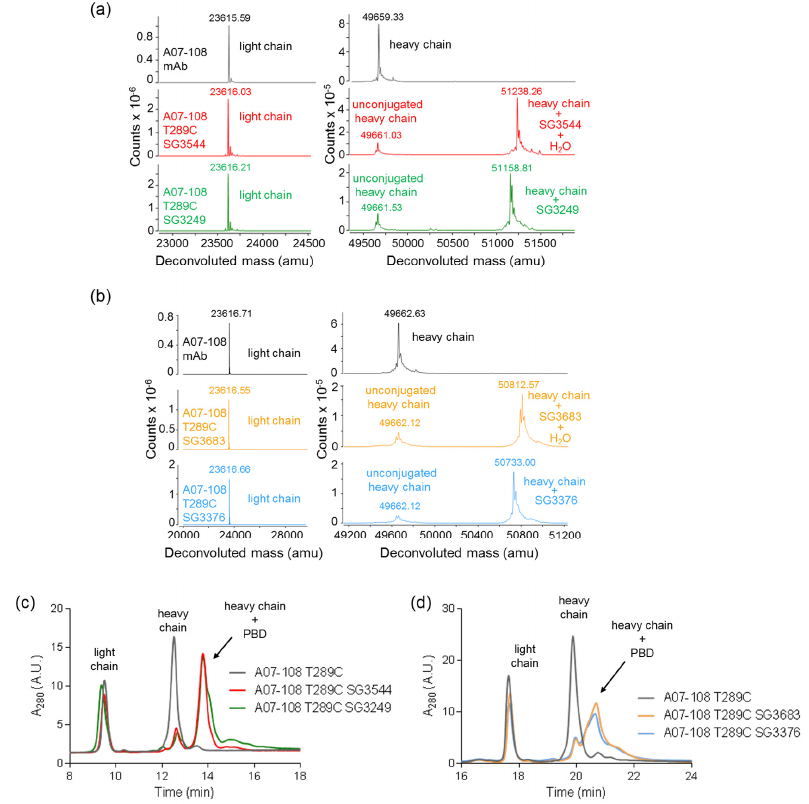
Figure 2. Characterization of A07-108 T289C antibody-drug conjugates (ADCs). ( a ) Reduced deglycosylated mass spectrometry analysis of antibody before and after conjugation of cleavable pyrrolobenzodiazepine (PBD) drug-linkers SG3249 and SG3544; ( b ) Reduced deglycosylated mass spectrometry analysis of antibody before and after conjugation of non-cleavable PBD drug-linkers SG3376 and SG3683; ( c ) rRP-HPLC analysis of antibody before and after conjugation to cleavable PBD drug linkers SG3249 and SG3544; and, ( d ) rRP-HPLC analysis of antibody before and after conjugation to non-cleavable drug-linkers SG3376 and SG3683. Antibody light chain, unconjugated heavy chain and conjugated heavy chain are indicated. Spectra are zoomed in to show light chain and heavy chain regions in both ( a , b ).